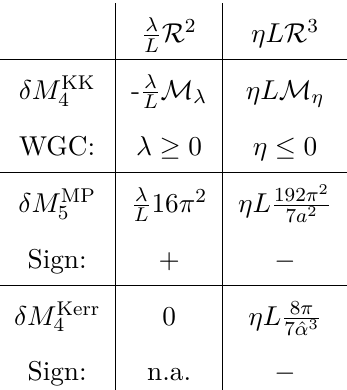
Table 1 . Overview of the four and six-derivative corrections to the extremal mass of the different black holes studied in this paper. The functions M both higher derivative corrections decrease the mass fixes the sign of the corrections to an extremal five-dimensional Myers-Perry and four-dimensional Kerr black hole. A + sign indicates an increase and a − sign a decrease in